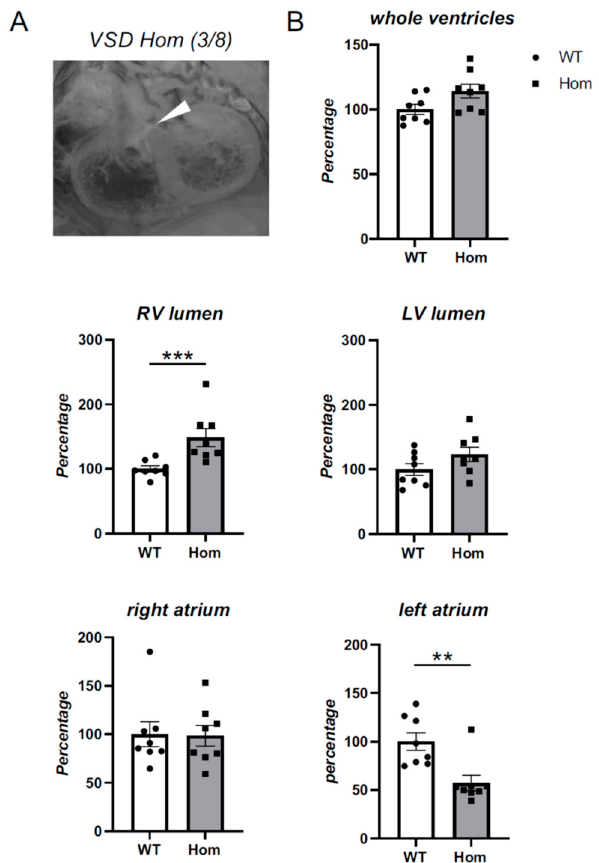
Figure 2. Homozygous embryos show gross structural heart defects. ( A ) HREM image of an E15.5 homozygous heart with a peri-membranous ventricular septal defect (VSD, white arrowhead). ( B ) Total volume of several heart compartments relative to control hearts was determined using Amira software. Percentage volume was assessed for whole ventricles (including myocardial wall and lumen), right (RV) and left ventricular (LV) lumens, right and left atria (including myocardial wall and lumen). Statistical significance was tested by one-tailed Fisher’s exact test ( A ), or Mann–Whitney tests. n = 8 WT (white bars), n = 8 Hom (grey bars) ** p < 0.01, *** p < 0.001. ( p = 0.0025, 19%) and descending thoracic aorta ( p = 0.0497, 32%, Figure S10B), but